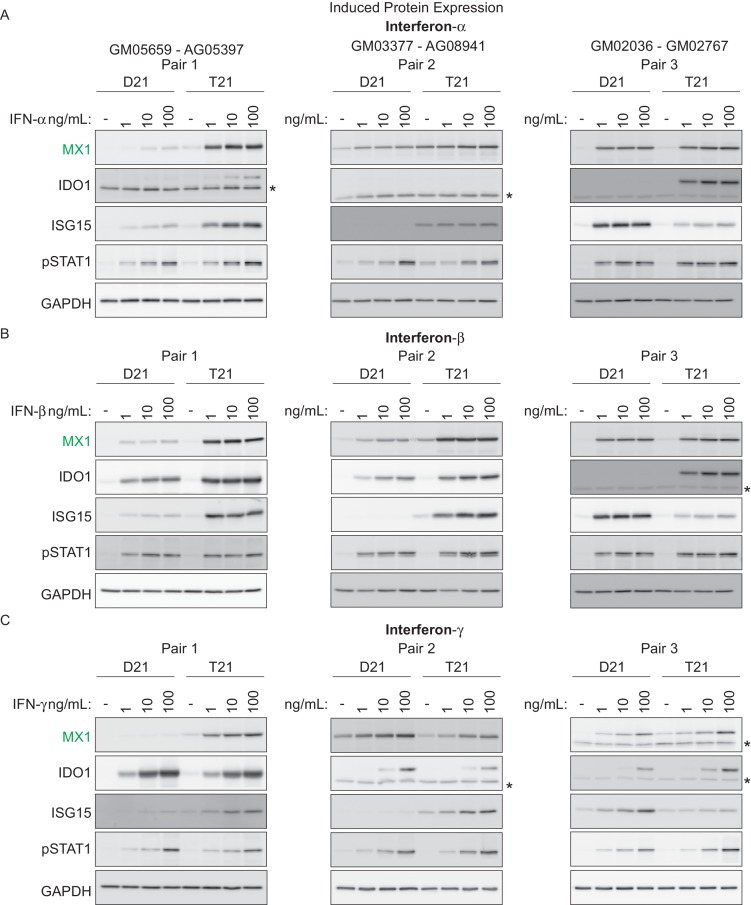
T21 fibroblasts are more sensitive to IFN stimulation than D21 fibroblasts.(A) Western blots showing that three T21 cell lines are more sensitive to IFN-α treatment (24 hr) than age- and gender-matched D21 control cells as measured by induced expression of the ISGs MX1, IDO1 and ISG15. Elevated pSTAT1 levels confirm effective induction of the IFN pathway in response to ligand exposure. (B) Western blots as in A for IFN-β treatment. (C) Western blots as in A for IFN-γ treatment. * indicates non-specific bands.